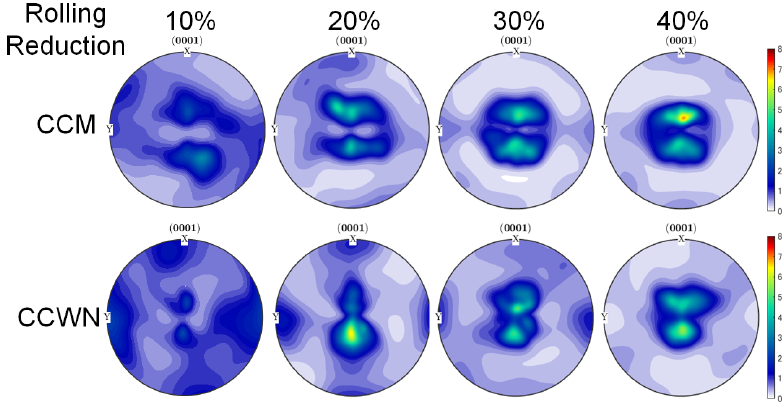
Figure 4. (0001) pole figures for hexagonal closest packed (HCP) martensite phases in the CCM and CCWN alloys at various rolling reductions. The pole densities are expressed as multiples of the random density by